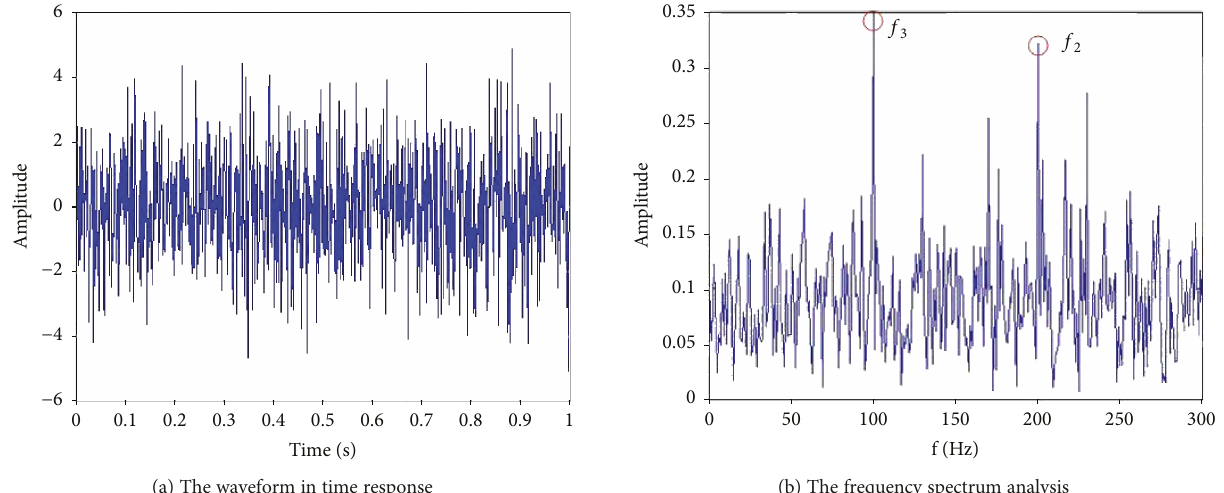
Figure 3: The synthetic signal of simulation.